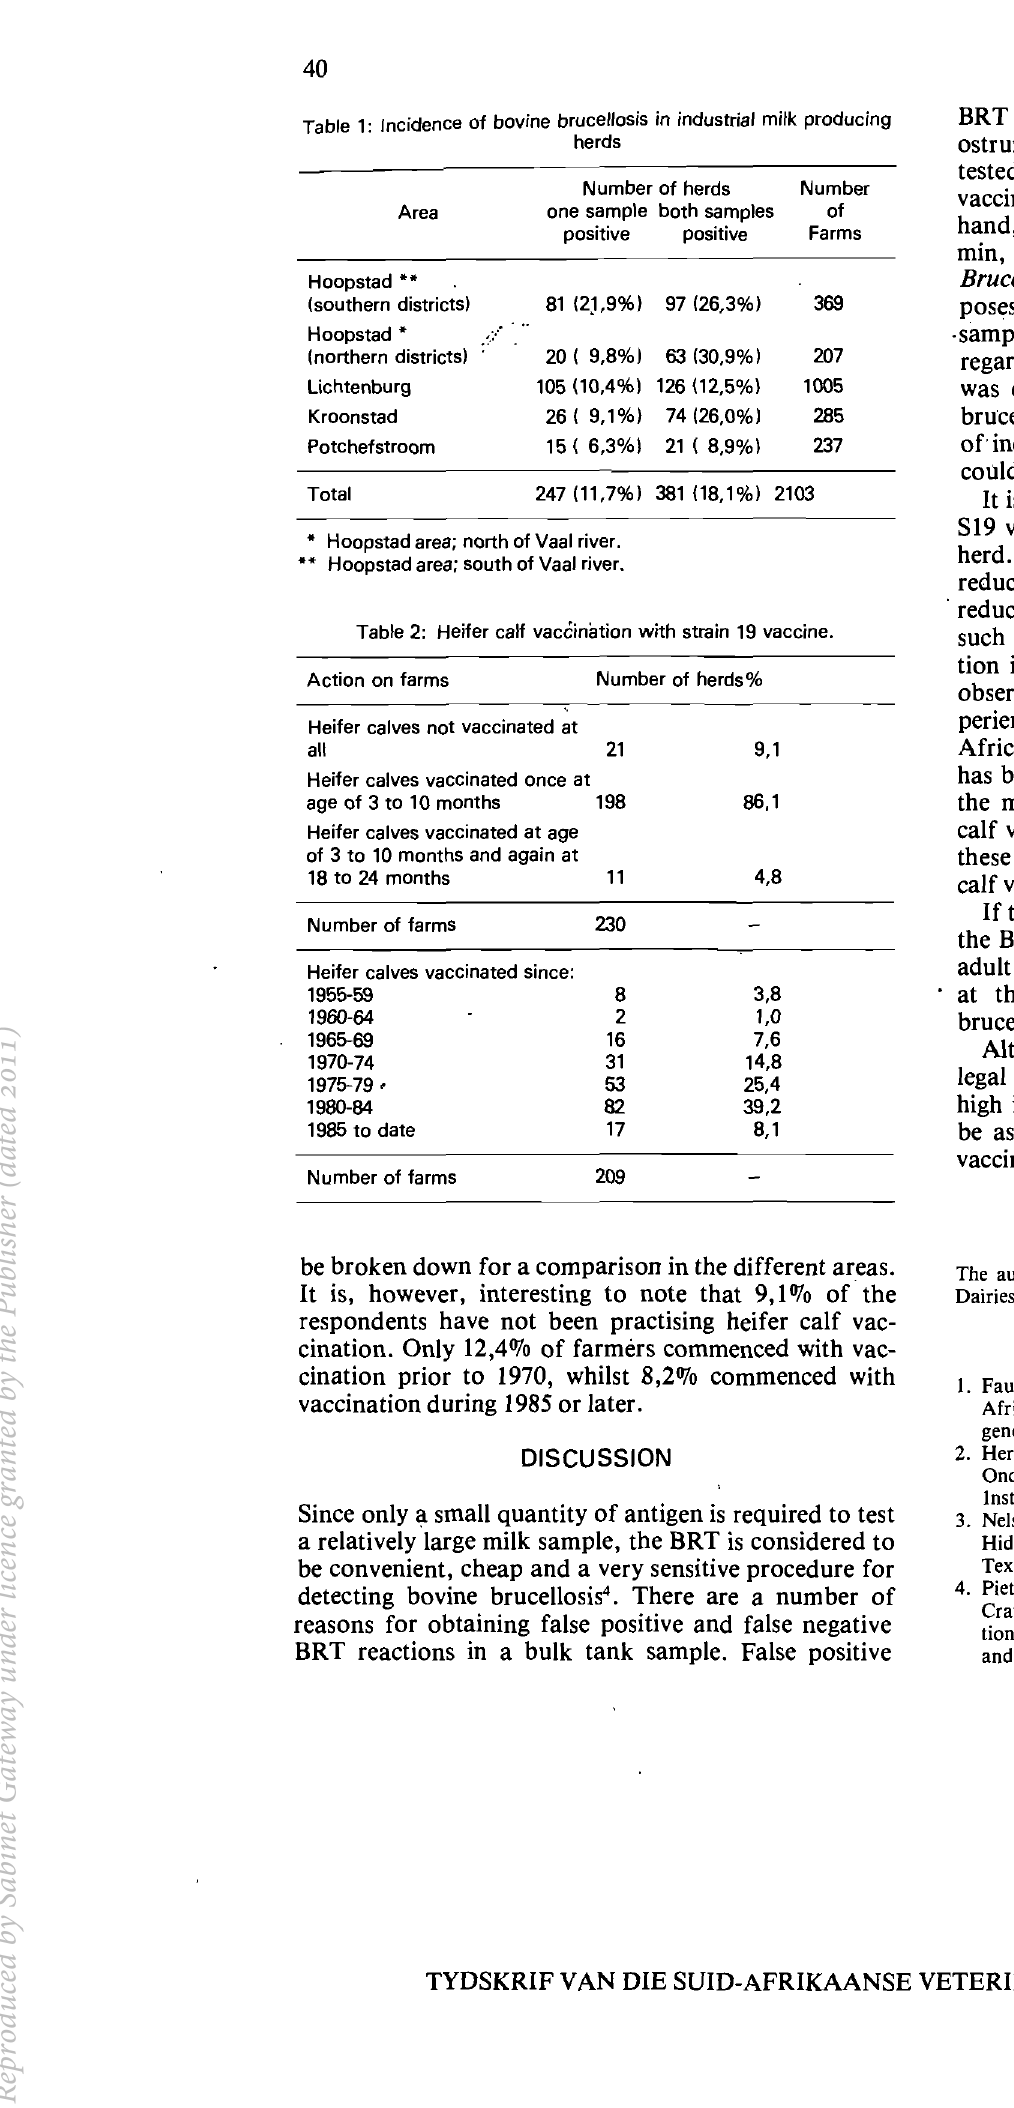
Number of farms